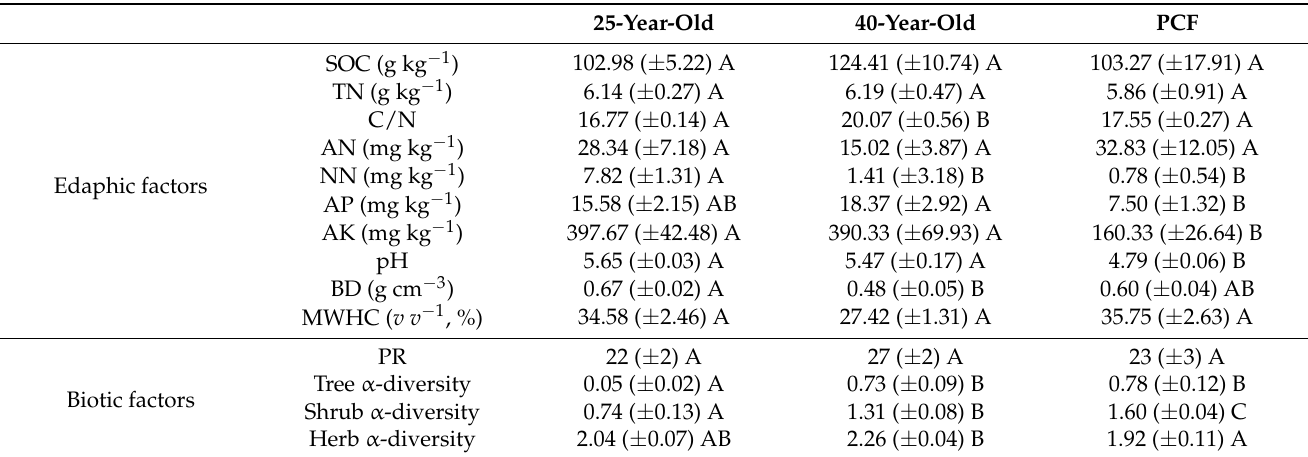
Table 7. Variation in the edaphic and biotic factors in the three stands.